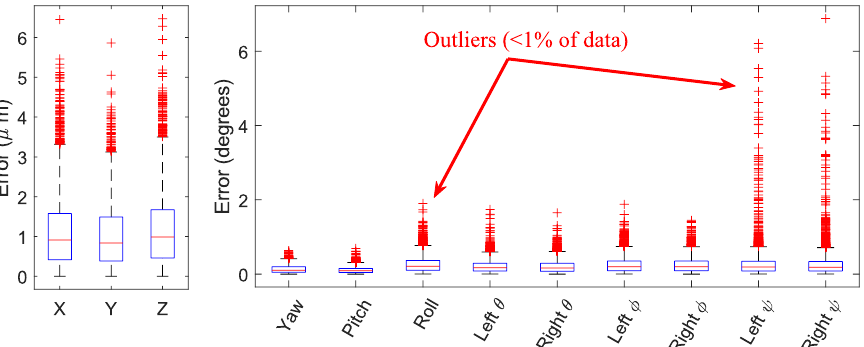
Figure 7. Model validation on synthetic data. Tracking errors box plot. Each box contains 75% of the data. Whiskers correspond to 99.3% of the data.